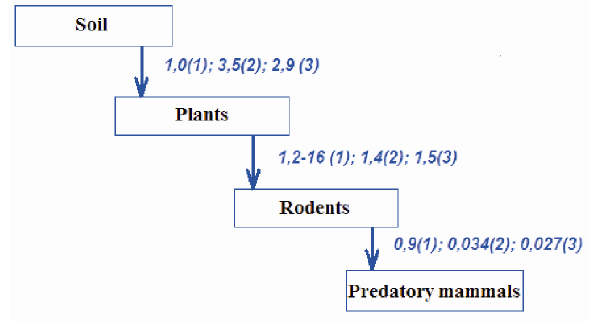
137 Fig. 14. Values of Cs transfer coefficients in fox trophic chain: 1 – Радиоэкология... 1977; 2 – Resrad biota 2004; 3 – research determined; 4 – EPIC... 2003